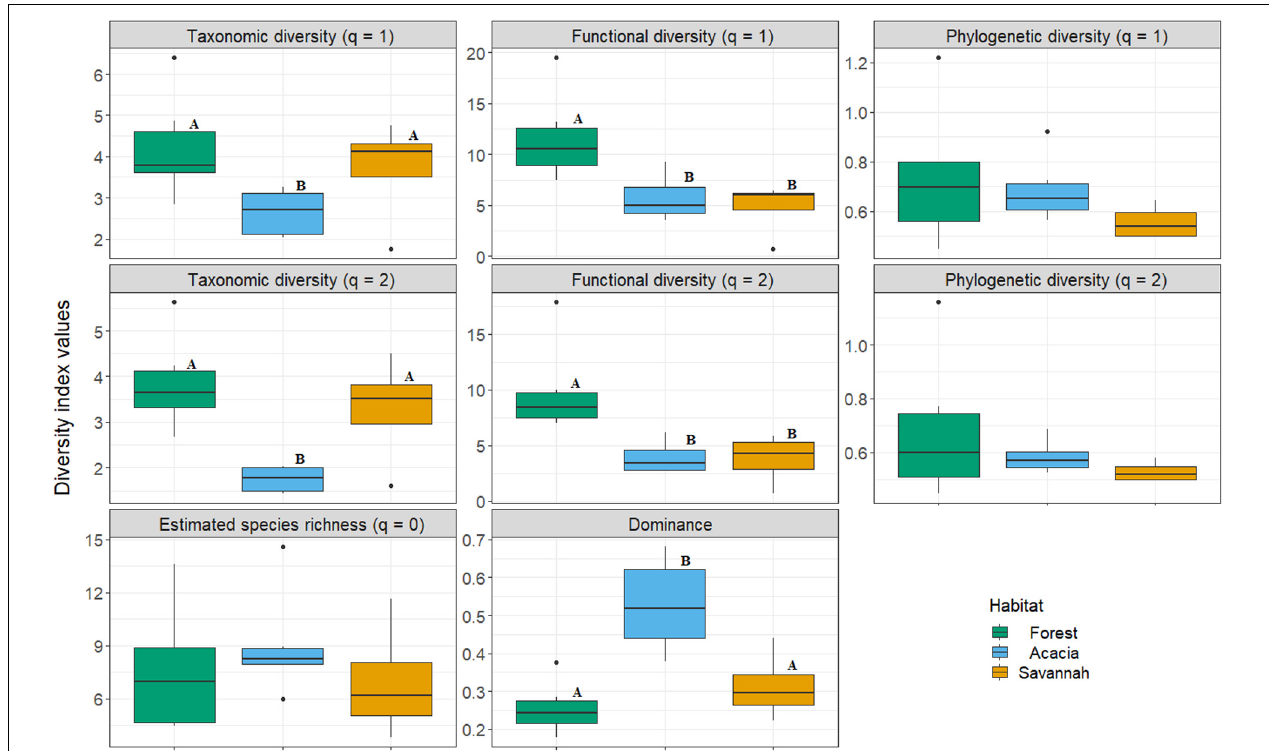
FIGURE 1 | Comparison of taxonomic, functional, and phylogenetic diversity, as well as species richness and dominance of bat assemblages sampled in the forest, savannah and acacia plantations in the northern Brazilian Amazon in 2017. Different letters indicate a significant difference for diversity indices between habitats.